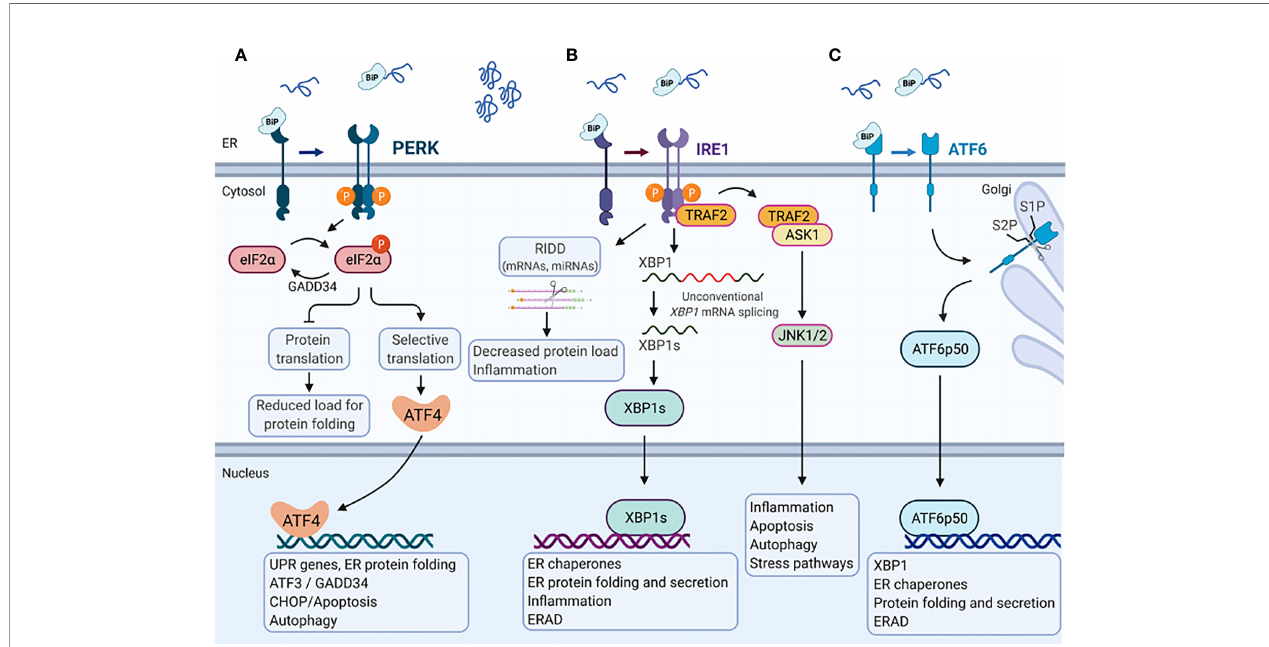
FIGURE 2 | Endoplasmic reticulum stress-mediated Unfolded protein response. In the absence of ER stress, the ER chaperone protein GRP78/BiP is bound to the three major branches of the unfolded protein response (UPR) (A) PERK, (B) IRE1, and (C) ATF6 and keeps them in an inactive state. Upon accumulation of misfolded or unfolded proteins that cause Endoplasmic reticulum (ER) stress, GRP78/BiP dissociates from these receptors and binds to misfolded proteins, which activates the UPR signaling proteins. (A) PERK phosphorylates eukaryotic translation initiation factor 2 subunit- a (eIF2 a ), decreasing mRNA translation. However, speci fi c mRNAs (e.g., ATF4) mRNA can be translated in the presence of phosphorylated eIF2 a . ATF4 activates the transcription of UPR target genes that encode proteins involved in ER protein folding, autophagy and apoptosis (e.g., CCAAT/enhancer- binding protein homologous protein (CHOP) and GADD34). GADD34 targets protein phosphatase 1 (PP1) to dephosphorylate eIF2 a which reactivates mRNA translation. (B) IRE1 a has endoribonuclease activity and splices XBP1 mRNA to XBP1s, which encodes a transcription factor that activates expression of UPR target genes such as chaperones, ER folding and secretion, in fl ammation and ERAD. Activation of the IRE1 a endoribonuclease activity can also induce the degradation of mRNAs encoding membrane or secreted proteins by regulated IRE1-dependent decay (RIDD), which affects the protein folding load, in fl ammation and in fl ammasome signaling. The cytosolic domain of IRE1 a is also able to interact with tumor necrosis factor receptor-associated factor 2 (TRAF2), which can activate ASK1 and JNK1/2 to mediate in fl ammation, apoptosis, autophagy and stress pathways. (C) ATF6 moves from the ER to the Golgi apparatus, where it is cleaved by site-1 protease (S1P) and site-2 protease (S2P). The cleaved product (ATF6p50) migrates to the nucleus and activates the transcription of XBP1 as well as genes that are involved in ER protein folding and secretion, encode ER chaperones, and ERAD components. Created with